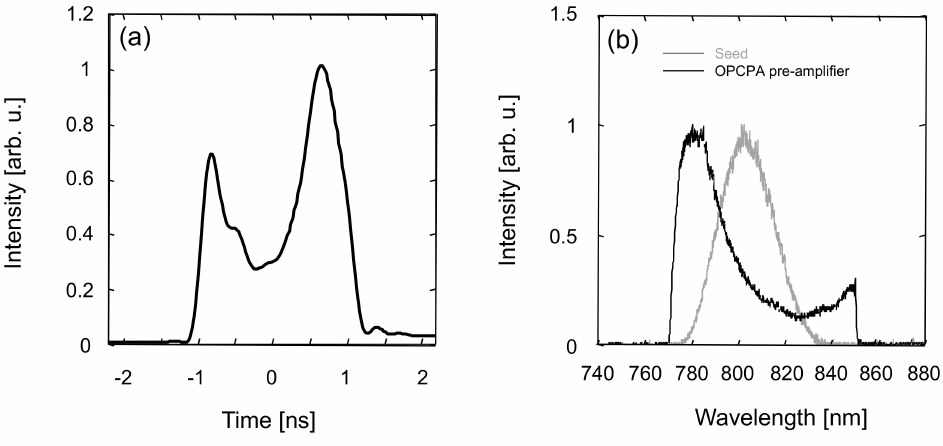
Figure 3. ( a ) Representative measured temporal profile of the pump laser for the OPCPA pre-amplifier for broadband amplification. ( b ) Representative measured spectra of the seed (gray line) and output of the OPCPA pre-amplifier for the broadband amplification pumped by a temporally shaped laser (black line).